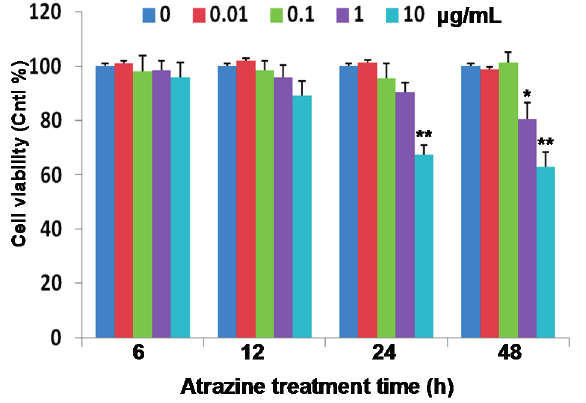
Figure 1. Effects of atrazine on the viability of MCF-10A breast epithelial cells. Cells (1.0 × 10 4 ) were incubated for 6, 12, 24 and 48 h in the presence of the indicated concentrations of atrazine or the vehicle (DMSO) control. Cell viability was assayed using an MTS proliferation assay kit. Results are presented as viabilities relative to controls. Experiments were repeated three times ( n = 4). Data represent the mean ± SD. * p < 0.05; ** p < 0.01 vs.